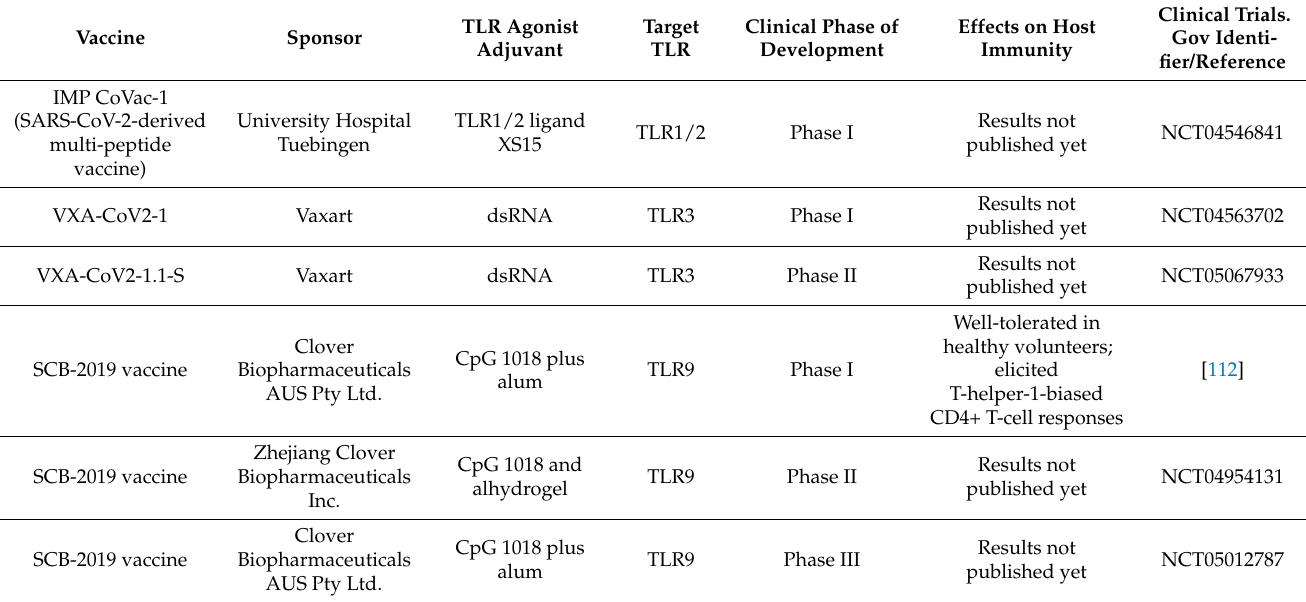
Table 1. TLR agonists as vaccine adjuvants for enhancing COVID-19 vaccine